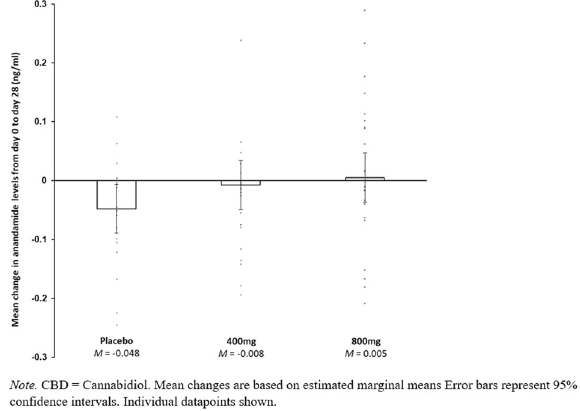
Fig. 5 Within-group changes in anandamide levels from day 0 to day abstinent from cannabis) or withdrawal symptoms between day 0 to day 28, within CBD and placebo groups (all p values > .05). coef fi cients between placebo, 400 mg CBD and 800 mg CBD symptoms.